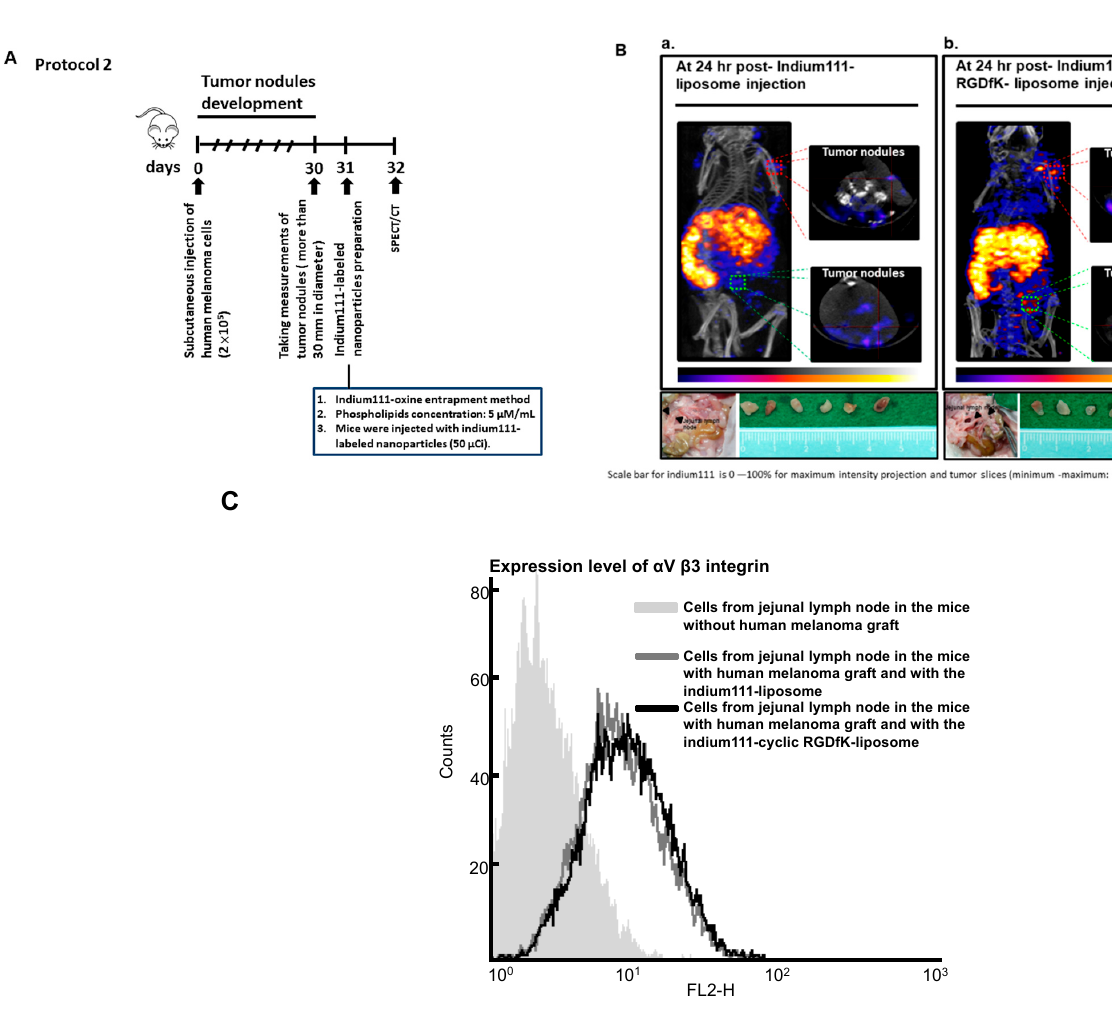
Figure 3. Non-invasive imaging with Nano SPECT/CT in mice with a metastatic growth of human melanoma cells. ( A ) Experimental scheme; ( B ) The nude mice with human melanoma were injected with the 111 In-liposome (panel a) and with the 111 In-labeled-cyclic RGDfK-liposome (panel b), and images was captured at 24 hr post- radioactive liposomes injection. The tumors found around jejunal lymph node were dissected. ( C ) The measurement of α V β 3 integrin expression by flow cytometry. The figure showed here was a representative example of three independent experiments in which each group consisted of three mice. Table 2. The percentage of injection dose of the 111 ln-cyclic RGDfK-liposome or the 111 ln-liposome in the tissuesamples and the radioactivity proportion of tumor to blood in the mice with a metastatic growth of human melanomacells.